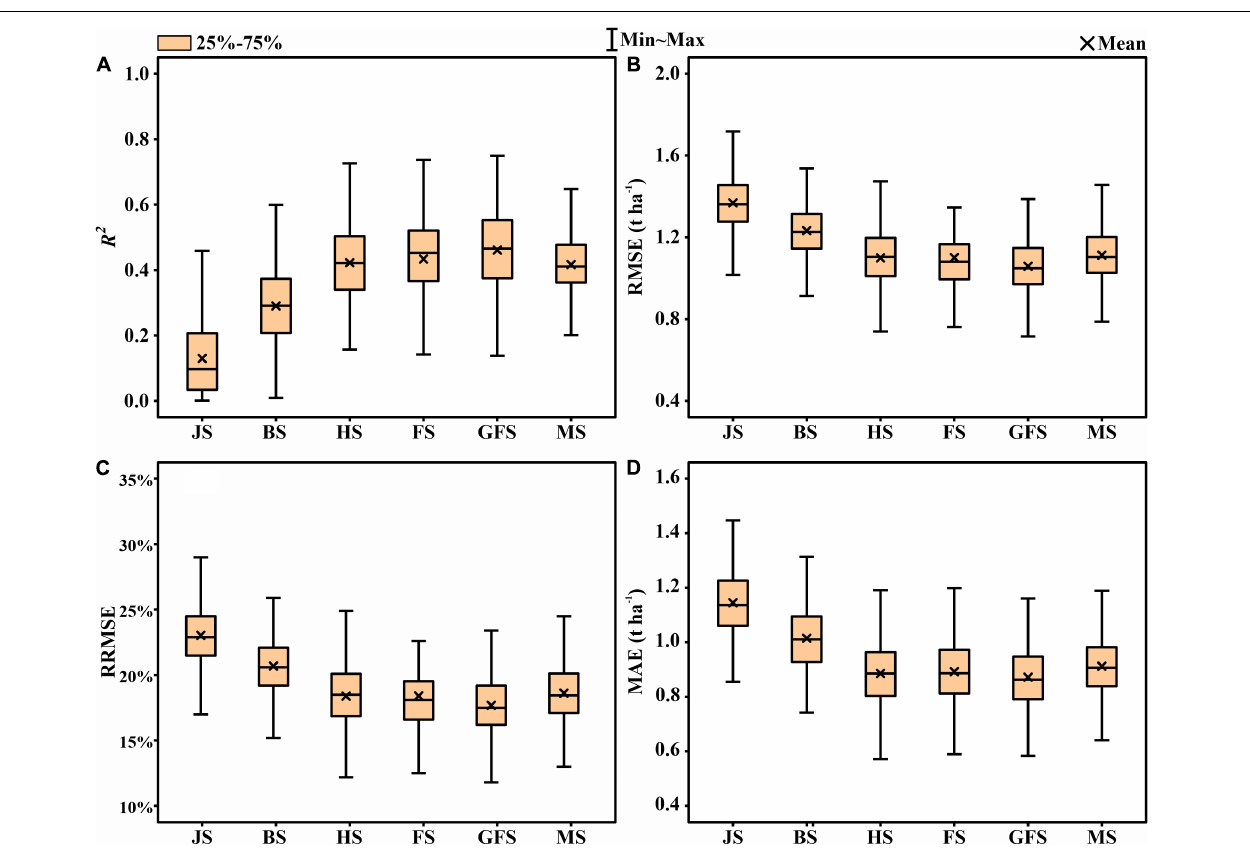
and 0.684 t ha − 1 , respectively. A low prediction was observed in C1 ( R 2 = 0.681). Compared to C5 ( R 2 = 0.692), C6 ( R 2 = 0.678), C7 ( R 2 = 0.677), and C8 ( R 2 = 0.688), C2 ( R 2 = 0.721) and